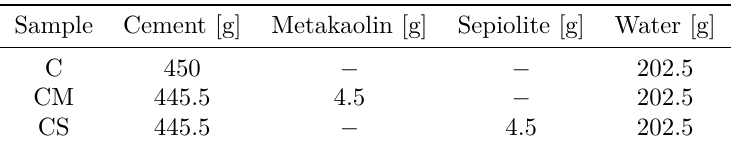
Table 1. Composition of cement pastes.